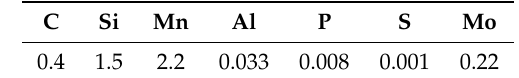
Table 1. Chemical composition (wt %) of the steel used in this study. C